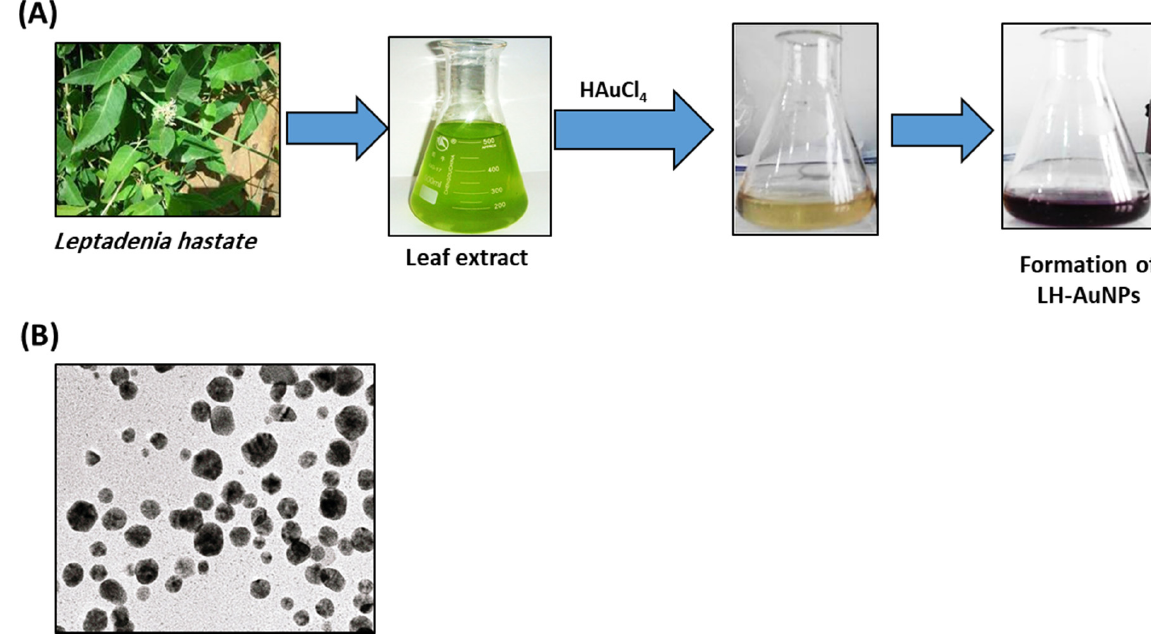
Figure 1. Biosynthesis of LH-AuNPs using L. hastate leaf extract. ( A ) The biosynthesis of LH-AuNPs was performed by combining L. hastate leaves powder (10 g) with 50 mL of 95% ethanol for 24 h at 37 °C in a 200 mL Erlenmeyer flask; 5 mL of the plant extract was added to 1 mM aqueous HAuCl4 solution (45 mL). The solution changed color from pale yellow to vivid ruby-red, signifying the formation of AuNPs. ( B ) TEM image of LH-AuNPs showed spherical or hexagonal shapes with lattice fringes s with sizes ranging from 5 to 30 nm.